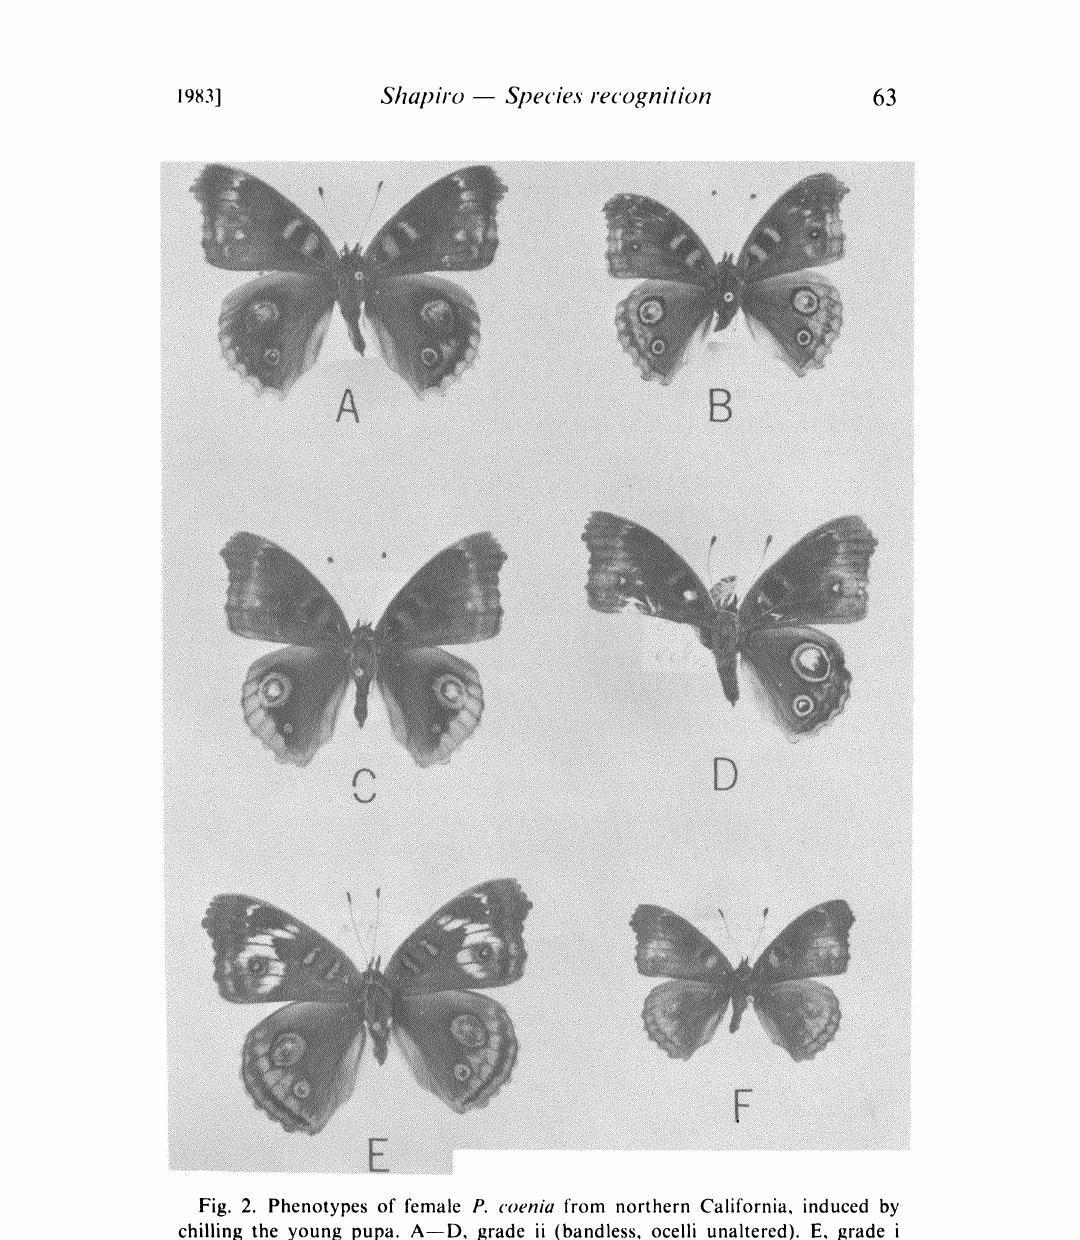
Fig. 2. Phenotypes of female P. coenia from northern California, induced by chilling the young pupa. A--D, grade ii (bandless, ocelli unaltered). E, grade (essentially unaltered). F, grade iii (bandless, ocelli